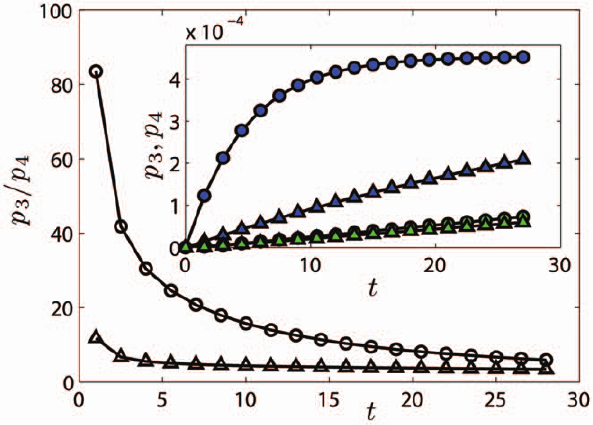
Figure 5. Probabilities p 3 and p 4 versus time for the TB- infection case. The probability p 3 of being in state 3 (TB reactivation) and p 4 of being in state 4 (Post 1 0 TB) are calculated from Eq. 7, using the parameters of Table 1 . In the main plot we compare the ratio p 3 = p 4 obtained from infliximab ( . ) and etanercept ( D ) parameters. In the inset, we depict each single probability, namely p 3 for infliximab (dark . ) and for etanercept (dark D ), p 4 for infliximab (bright . ) and for etanercept (bright D ); notice that the two sets of data for p 4 are partially overlapped. Lines are guide for the eye.